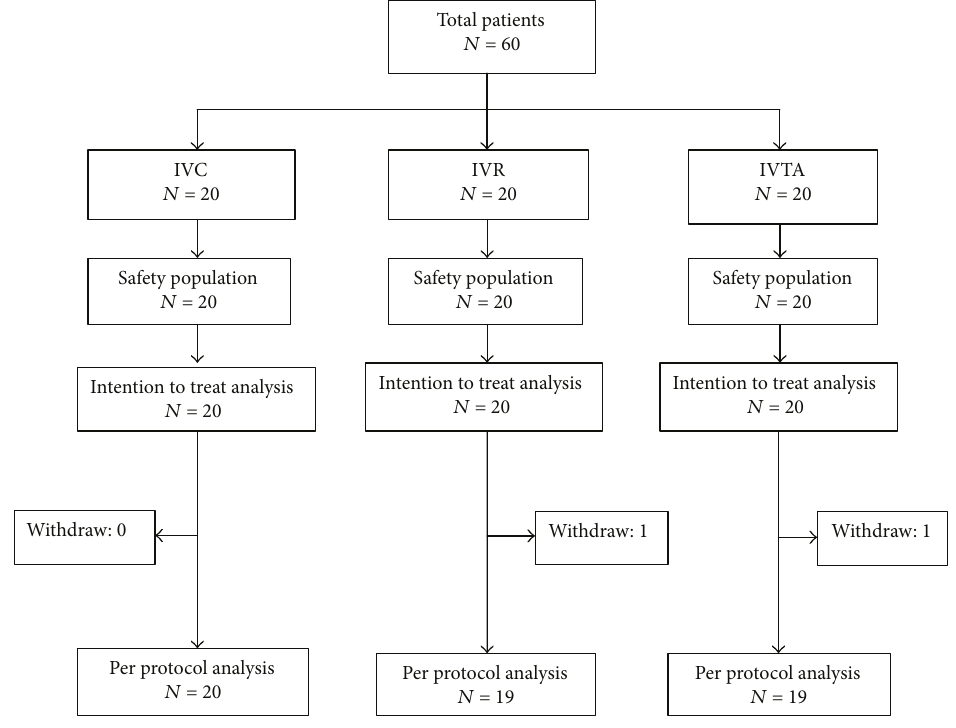
Figure 1: Study fl ow